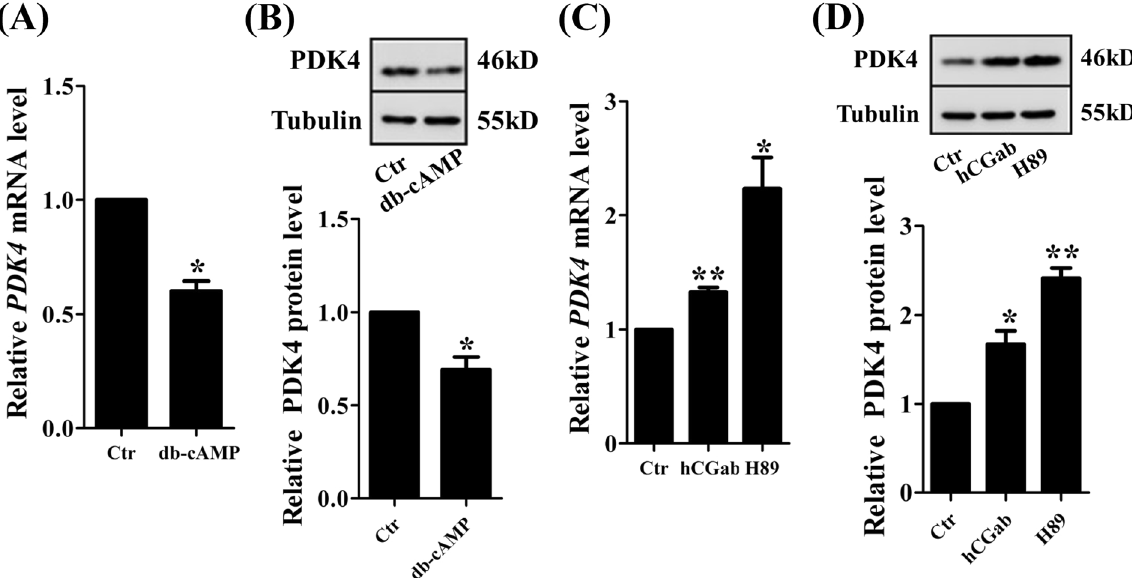
Figure 5. Role of activation of the cAMP/PKA signaling pathway by hCG in the regulation of PDK4 expression in human placental trophoblasts. ( A ) and ( B ) Treatment of trophoblasts with dibutyryl-cAMP (db-cAMP, 200 μ M) for 24 hours significantly decreased the amounts of PDK4 mRNA (n = 6, A ) and protein (n = 3, B ). ( C ) and ( D ) Treatment of trophoblasts with β -hCG antibody (hCGab, 1:100) or PKA inhibitor H89 (20 μ M) for 24 hours significantly increased the abundance of PDK4 mRNA (n = 4, C ) and protein (n = 3, D ). * P < 0.05; ** P < 0.01 against